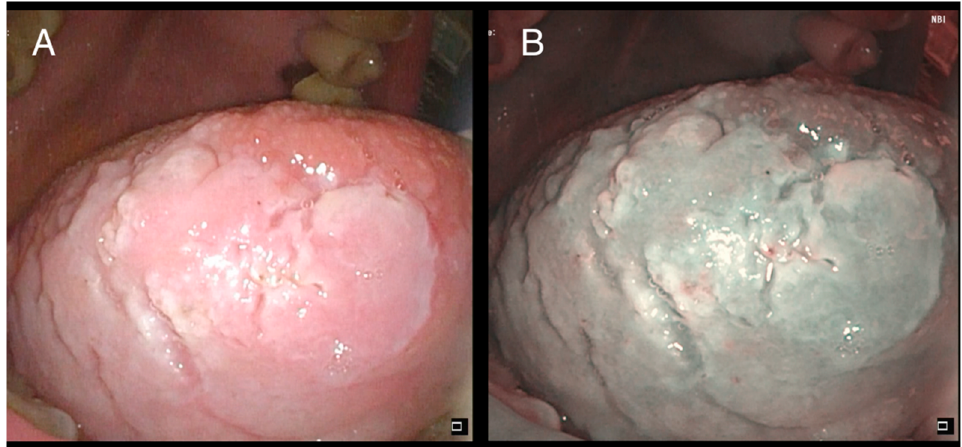
Figure 1. Low-grade dysplasia of the right tongue border: ( A ) white light; ( B ) narrow-band imaging (NBI).